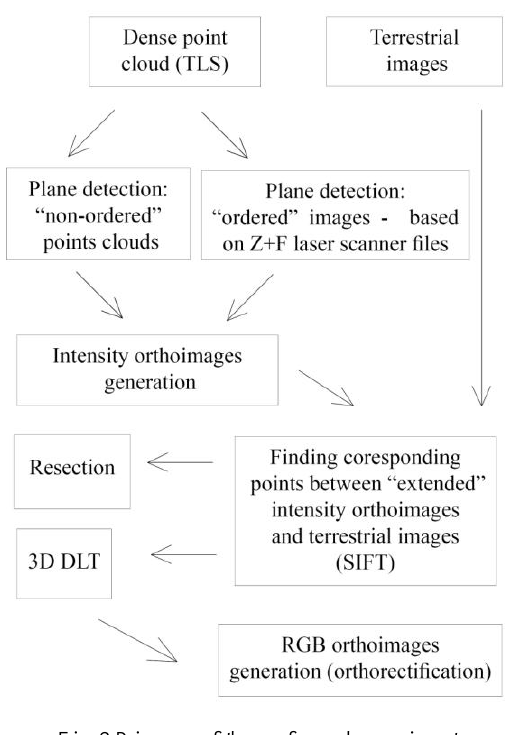
Fig. 2 Diagram of the performed experiment have developed their own application, which allows for automatic generation of these planes. The first experiments were performed using algorithms from the PCL library (Point Cloud Library). This library utilises RANSAC methods, i.e. it selects three points from the cloud and then it searches through the entire cloud in order to find points, which are located close enough the plane, which is determined by these three points. If the sufficient number of such points (inliners) exists, the plane is accepted; otherwise the selection of points is repeated. For the source data which includes 7 million points, after re-sampling 1:20, 12 areas were obtained, which corresponded to planes (colours in the figure 3), as well as some points, which were not classified into any plane (in grey). The assumed maximum deviation from the plane equalled to 5 cm. The time of computations 37 minutes. Since vertical and horizontal planes are important for documentary purposes, the author's algorithm was developed, which utilises the modified Hough transformation for these